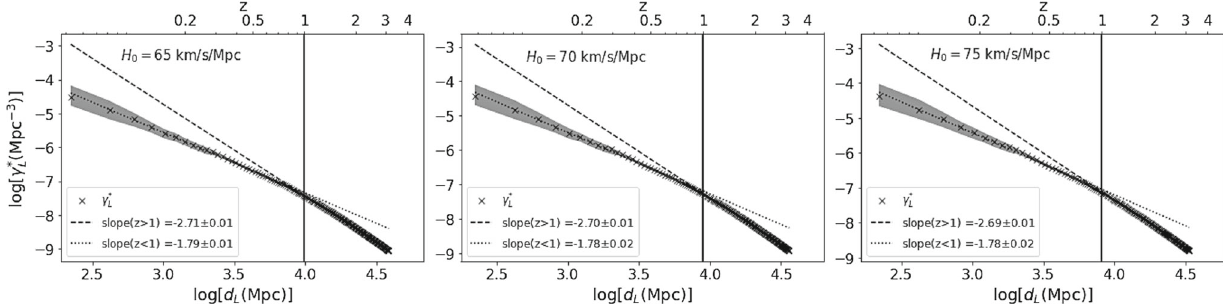
Fig. 4 Log–log graph of γ ∗ vs. d L obtained with the COSMOS2015 galaxy redshift survey dataset in the ranges z < 1 and 1 ≤ z ≤ 4 and L respective distance